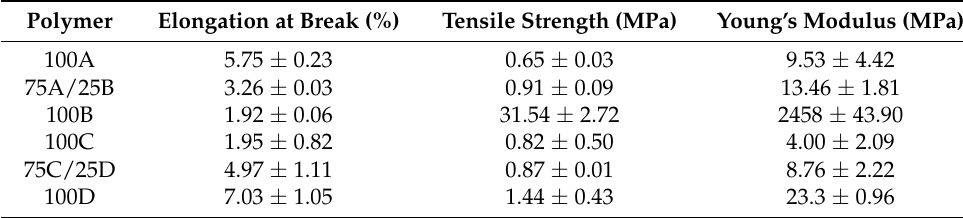
Table 5. Mechanical characteristics of polymers. Polymer Elongation at Break